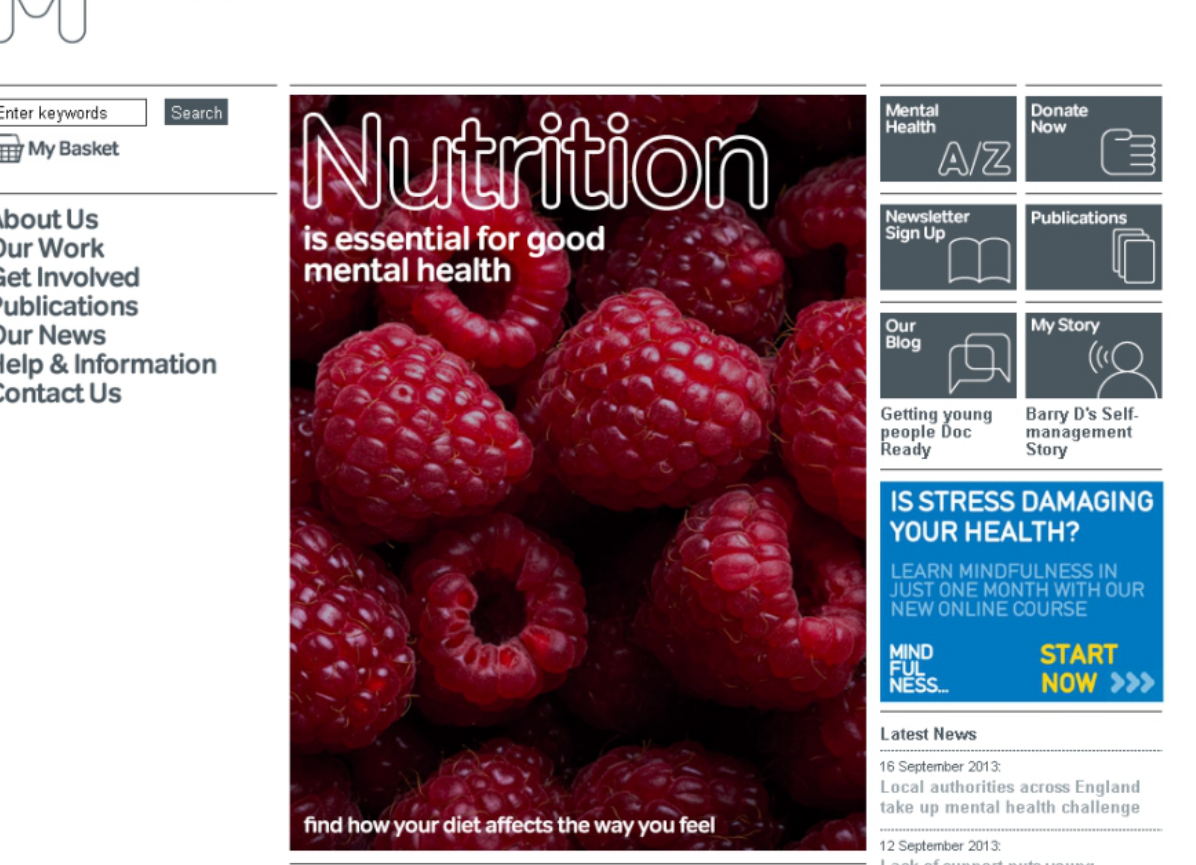
Figure 2. Example page from one control-arm